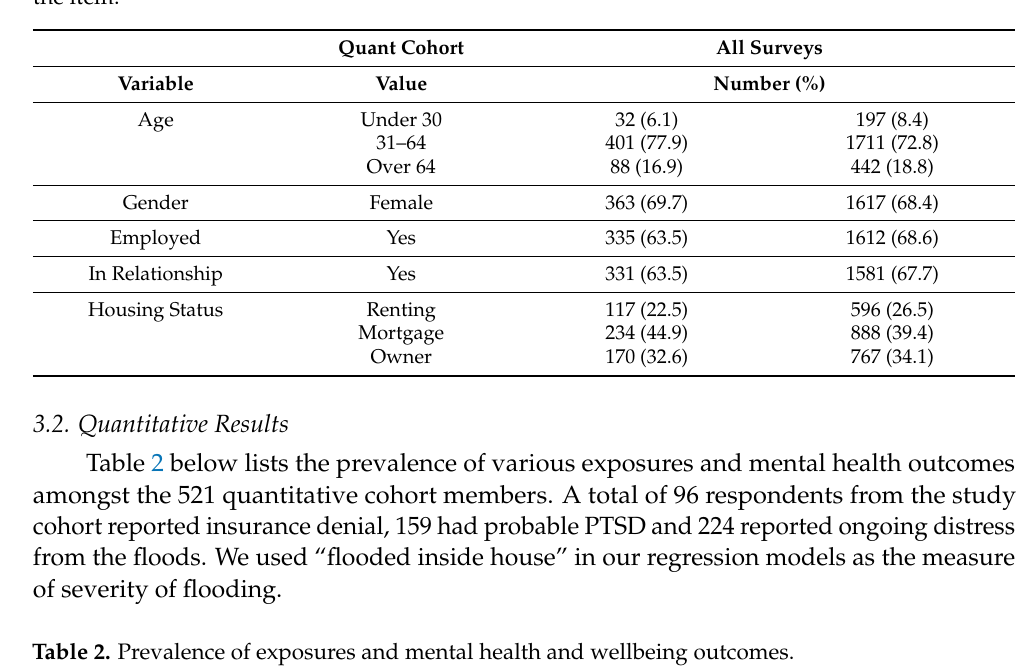
Table 1. Demographics of the quantitative study cohort ( n = 521) and all surveys that completed the item.